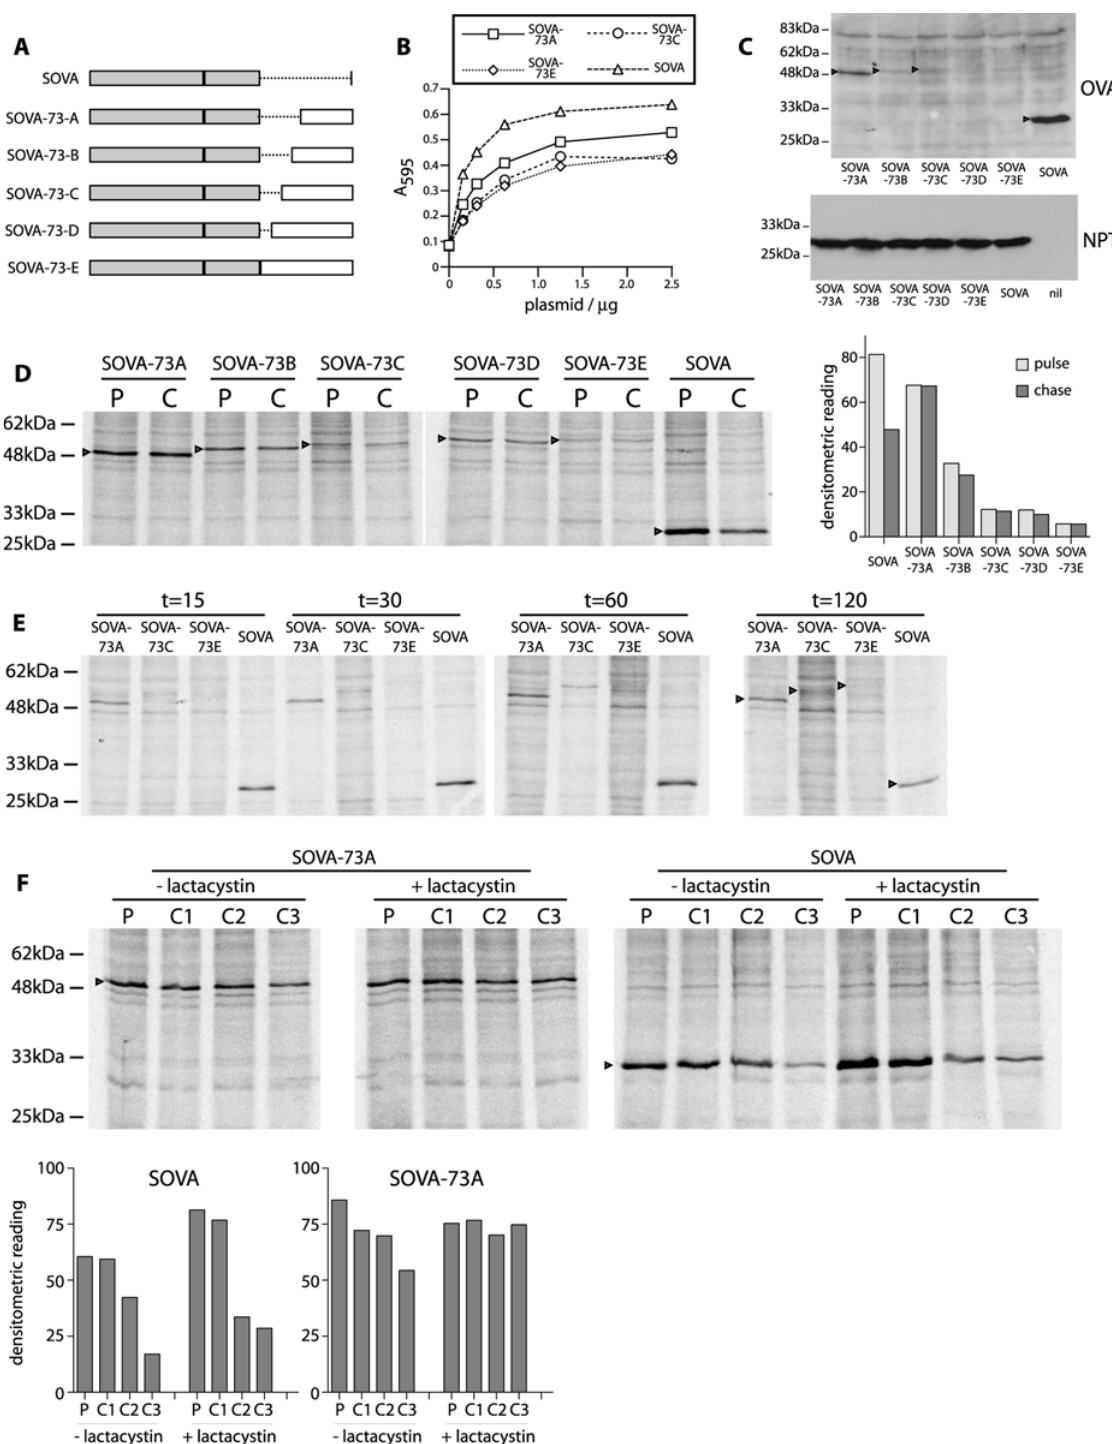
(D) Forty-eight hours after transfection with the constructs indicated, 293T cells were pulse-labelled (P) for 30 min with 35 S-cysteine/methionine, followed by a 2-h chase (C) with excess unlabelled cysteine/methionine. OVA derivatives were then immunoprecipitated with an OVA-specific rabbit serum and resolved by SDS-PAGE. The specific bands corresponding to each fusion protein are indicated by arrowheads. The graph shows densitometry readings for each band. (E) 293T cells transfected with selected fusion proteins were labelled for a variable period (15–120 min) as indicated. OVA derivatives were then immunoprecipitated and analysed as in (D). Arrowheads show the predicted position of the relevant fusion proteins for the 120-min label samples. (F) Either SOVA-ORF73A or SOVA was transfected into 293T cells. Forty-eight hours later the cells were pulse-labelled (P) for 15 min with 35 S- cysteine/methionine, followed by a 15-min (C1), 45-min (C2), and 105-min (C3) chase with excess unlabelled cysteine/methionine. This was done in the presence or absence of 100 l M lactacystin. The graph shows densitometry readings for each specific band. DOI: 10.1371/journal.pbio.0030120.g002 PLoS Biology |